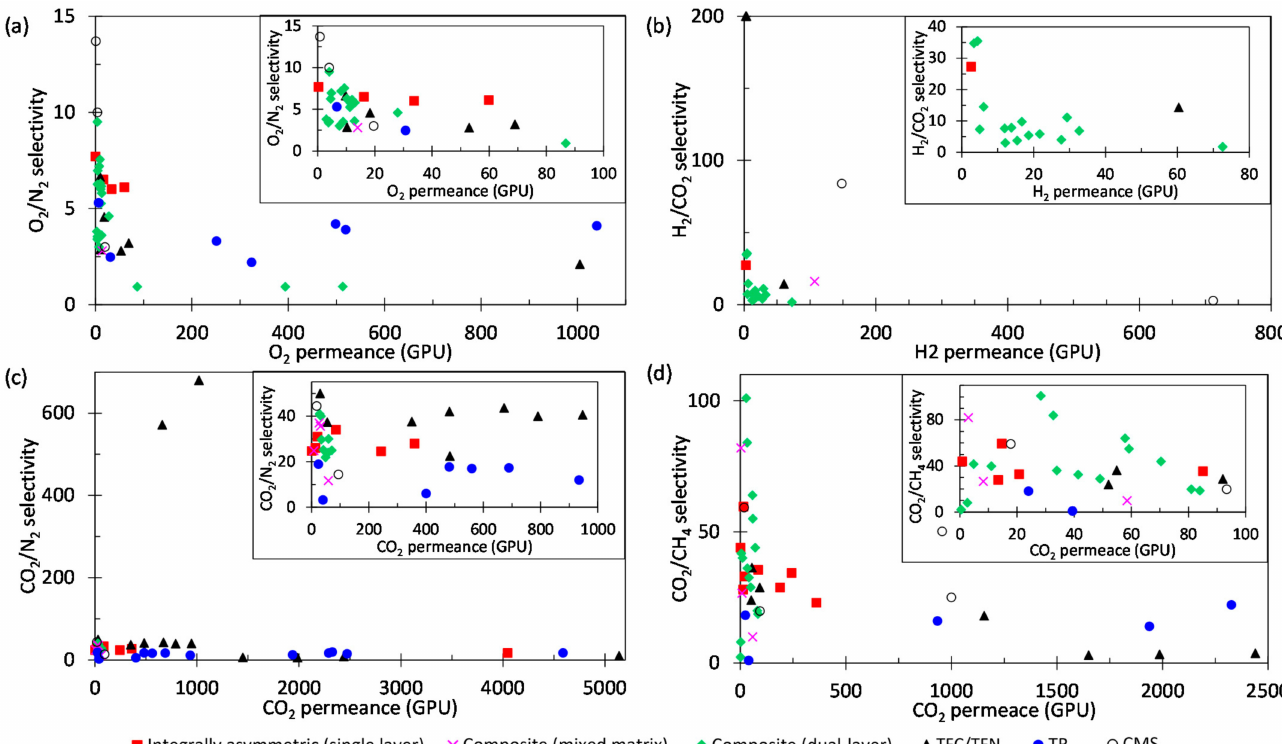
Figure 15. Performance plot on recent state-of-the-art hollow fiber membranes for ( a ) O 2 /N 2 , ( b ) H 2 /CO 2 , ( c ) CO 2 /N 2 , and ( d ) CO 2 /CH 4 . Inset is the magnified plot on the packed data